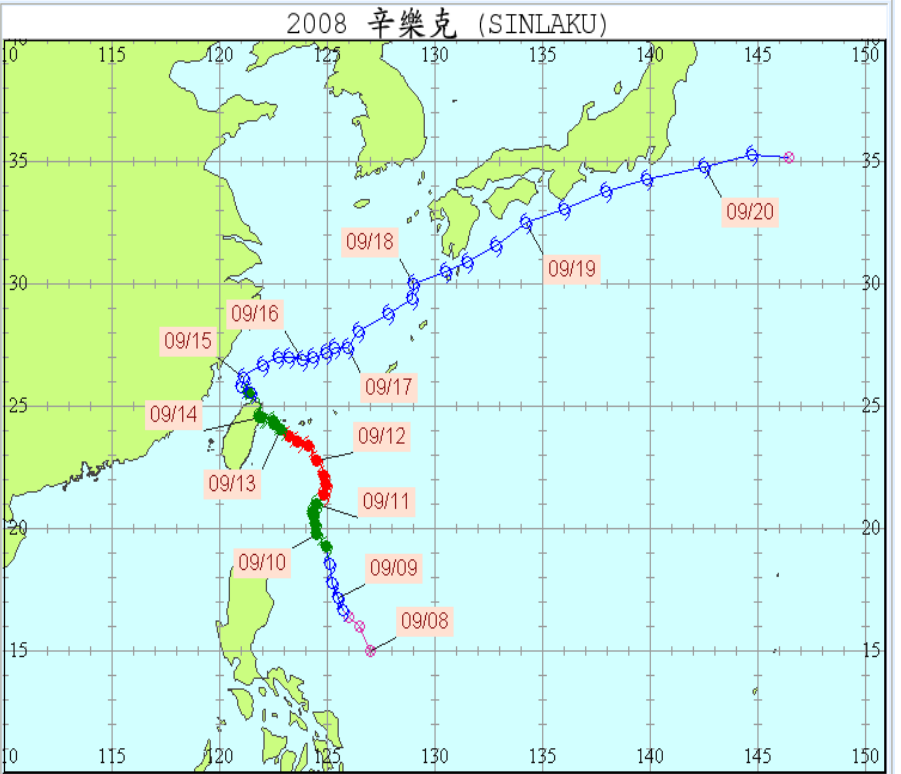
Figure 7. Path of Typhoon Sinlaku (Courtesy of CWB,